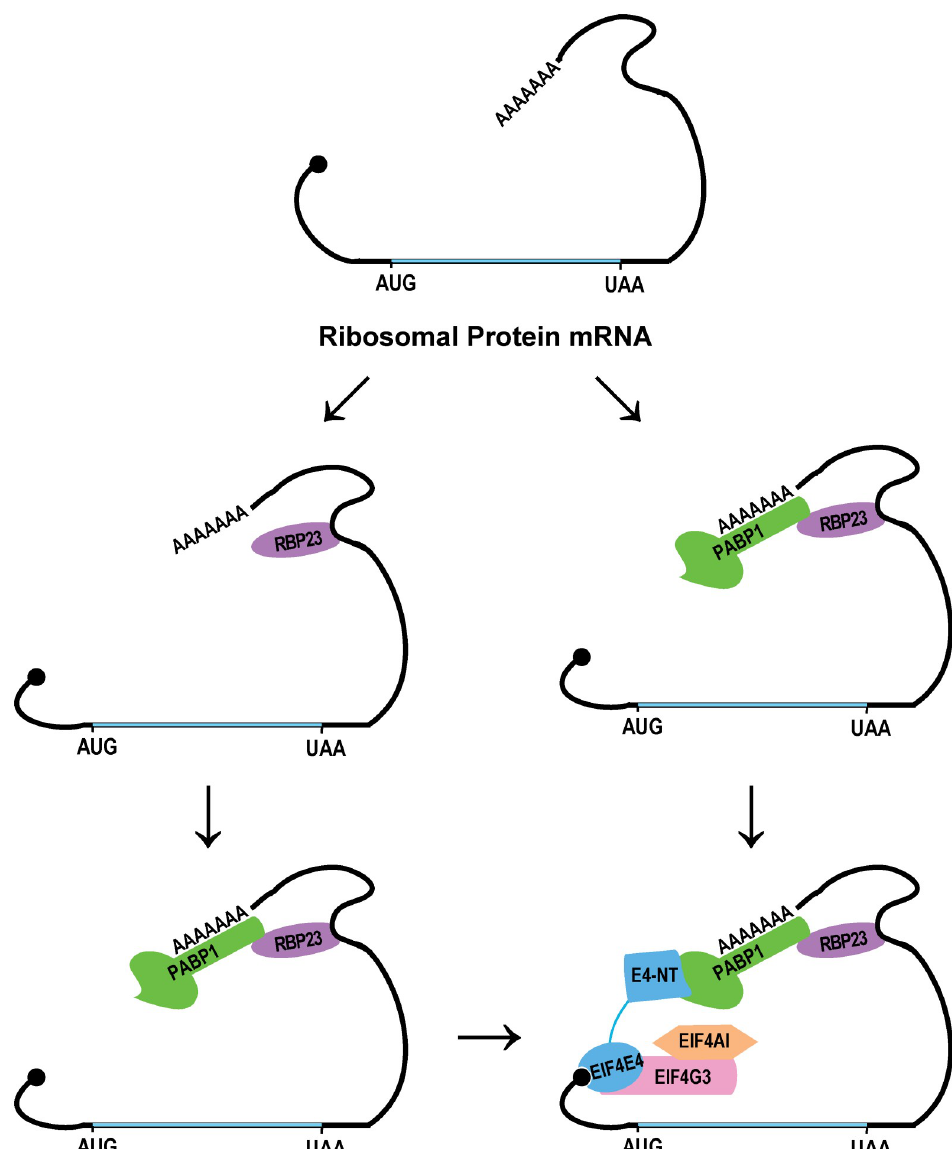
Fig 8. Proposed role for RBP23 in mediating the association of mRNAs encoding ribosomal proteins with PABP1 and the EIF4E4/EIF4G3/EIF4AI complex. According to the proposed model, RBP23 recognizes target mRNAs through motifs within their 3’UTRs. It might recognize these mRNAs on its own or already bound to PABP1. PABP1 then mediates the recruitment of the translation initiation complex EIF4E4/EIF4G3/EIF4AI. It is also possible that PABP1 might already be bound to the complex prior to mRNA recognition but this is not shown. Both PABP1 and EIF4E4 are also phosphorylated during exponential growth, allowing for a more refined regulation of their activity and, presumably, the translation of the ribosomal protein